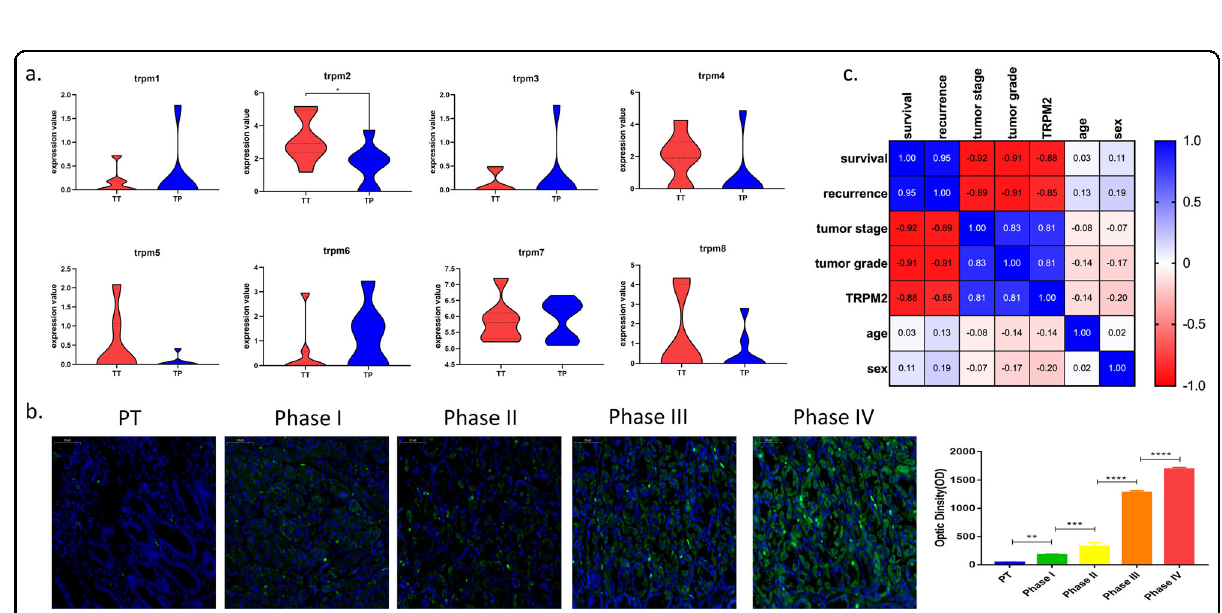
Fig. 2 High expression levels of TRPM2 in PA patients are associated with poor prognosis. a The mRNA level of TRPM 1 – 8 in transcriptome sequencing data for TT and TP in PA patients (12 samples each for TT or TP, * P < 0.05). b Immuno fl uorescence staining of TRPM2 in PT and different stages of TT tissues (12 samples for PT and 3 samples each for Stage I to IV TT samples, ** P < 0.01, *** P < 0.001, **** P < 0.0001). c Pearson ’ s coef fi cient in multivariate analysis for patients ’ clinical and sequencing